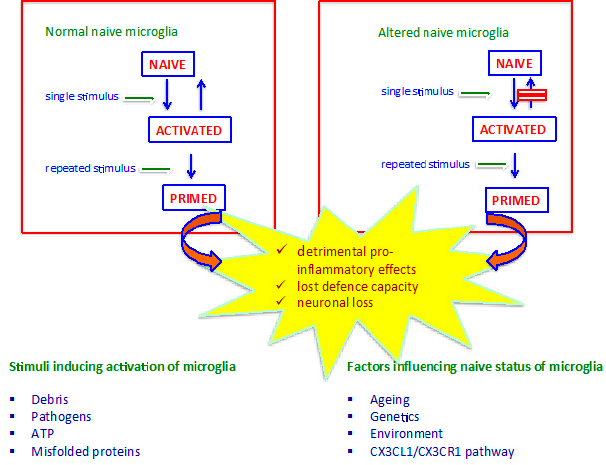
Figure 1. Microglia response upon stimuli should be effective and transient in order to face injury and avoid tissue damage deriving from excessive response. Once a stimulus activates microglia, they develop a protective, balanced response against injury, and then come back to the naïve state after the stimulus is eliminated. Upon repeated stimuli, microglia are primed via a toll-like receptor 4 (TLR-4)-mediated mechanism to enhance reactivity toward hit and pathogens. Both the efficacy and persistency of reactive microglia are influenced by the naïve, or baseline, steady-state status of these cells, which, in turn, is determined by a complexity of factors including genetics, ageing and neuron-to-glia communication. The latter maintains microglia in a quiescent, steady-state status, characterized by anti-inflammatory and neuroprotective behaviour. CX3CL1 is a critical modulator of neuron-to-glia interplay. Dysfunctional CX3CL1 signalling turns microglia toward a pro-inflammatory phenotype, resulting in an altered naive microglial status that tends to shift toward primed phenotypes earlier and easier than normal. Primed microglia emerge upon repeated stimuli and consist in microglia shifting towards less protective and more aggressive phenotypes, lacing the capacity to resolve inflammation and carrying out exclusively pro-inflammatory, detrimental effects. Primed microglia expose AD onset and progression and represent a promising target for a novel therapeutic approach in this disease. Table 2. Differences between activation and priming give rise to microglia phenotypes that display profoundly diverse features, with consequences on brain microenvironment health and homeostasis. Due to their characteristics, primed microglia are associated with AD onset and progression. Altered baseline microglia, such as dystrophic microglia resulting from ageing or dysfunctional CX3CL1 signalling-associated microglia, increase the tendency of activated phenotype of these cells to shift toward the primed one. Activation